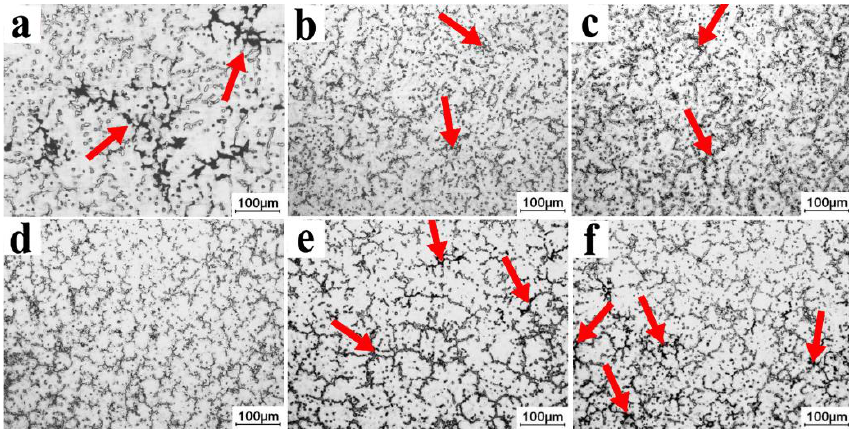
Figure 10. OM micrographs of the Grp/AZ91D composites with different holding times: ( a ) 0 min, ( b ) 5 min, ( c ) 10 min, ( d ) 15 min, ( e ) 20 min, and ( f ) 30 min. (Red arrows: the defects of composites).